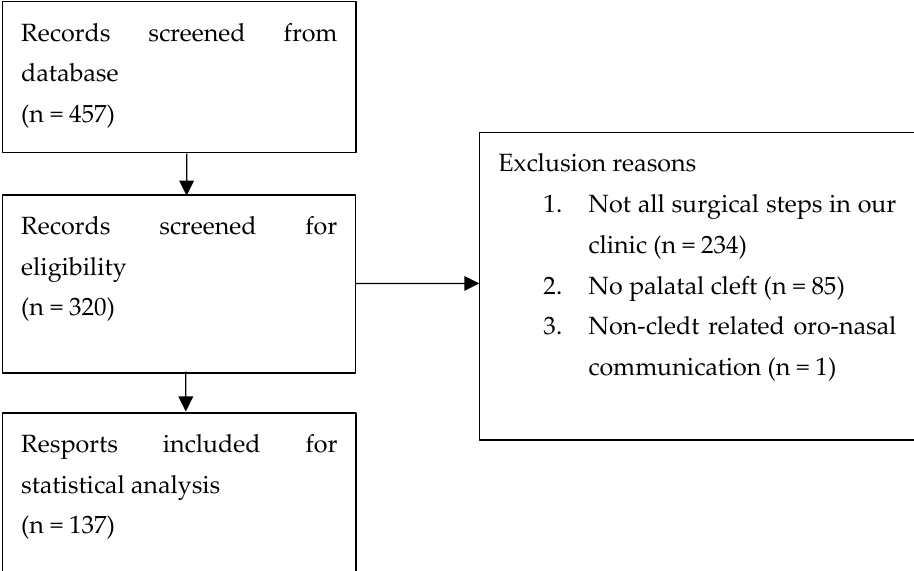
Figure 1. Summary of the patient records included in the study.